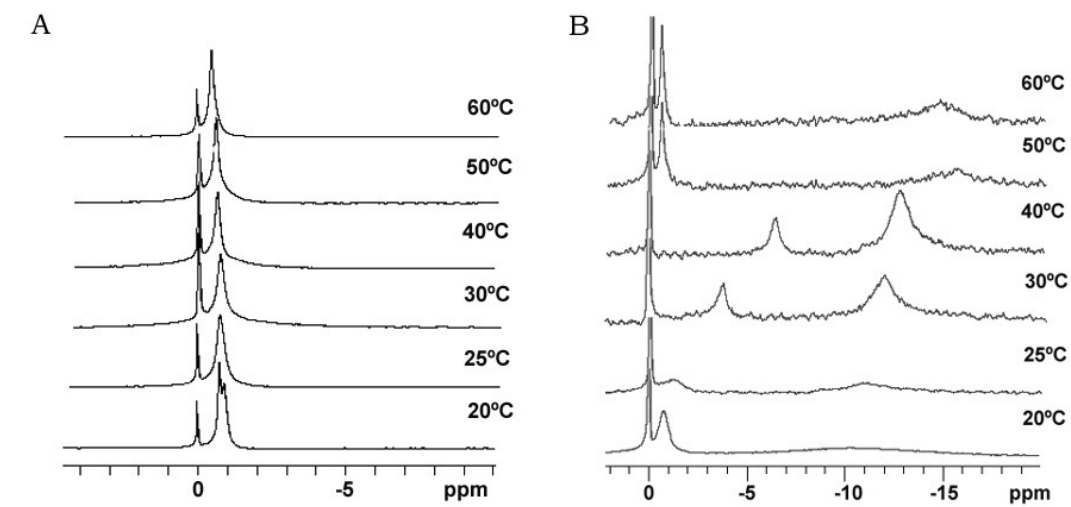
Figure 1. 31 P NMR spectra under 1 H decoupling as a function of temperature of the S-q2 system (left column) and the S-q3.5 system (right column). The temperature is indicated